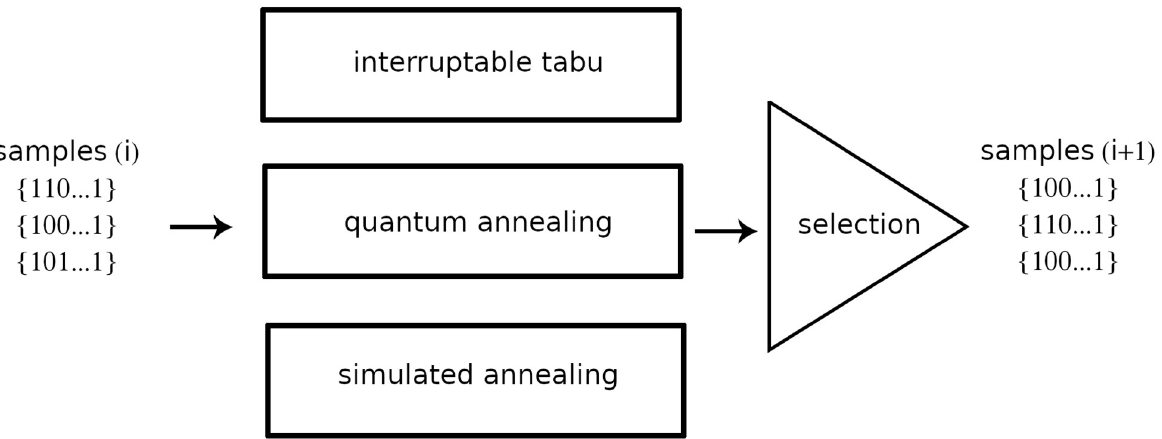
Fig 4. A simplified schematic of a single iteration cycle of three branches of solvers. The SA and TS solvers perform the classical hill-climbing optimization and provide redundancy in the case of decoherence errors in the quantum annealer. The quantum annealer extends the hill-climbing search with quantum tunnelling through optimization landscape barriers in the direction of the global